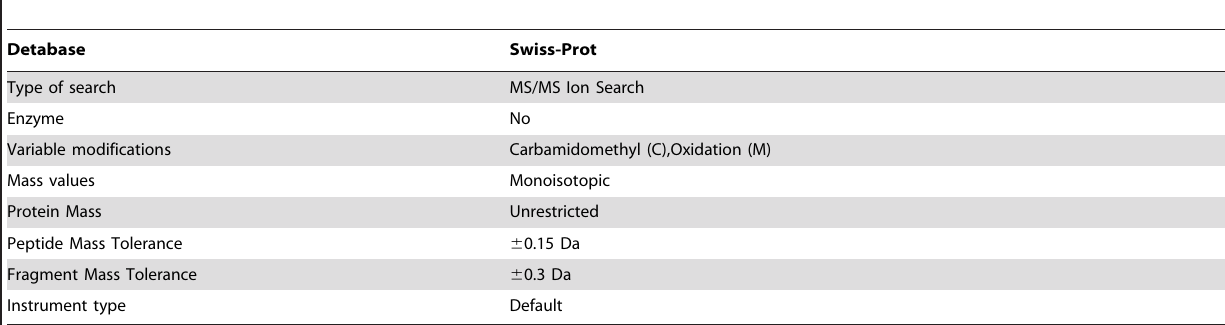
Table 1. The parameters of database searches with the MASCOT search engine using the GSP Explore software.